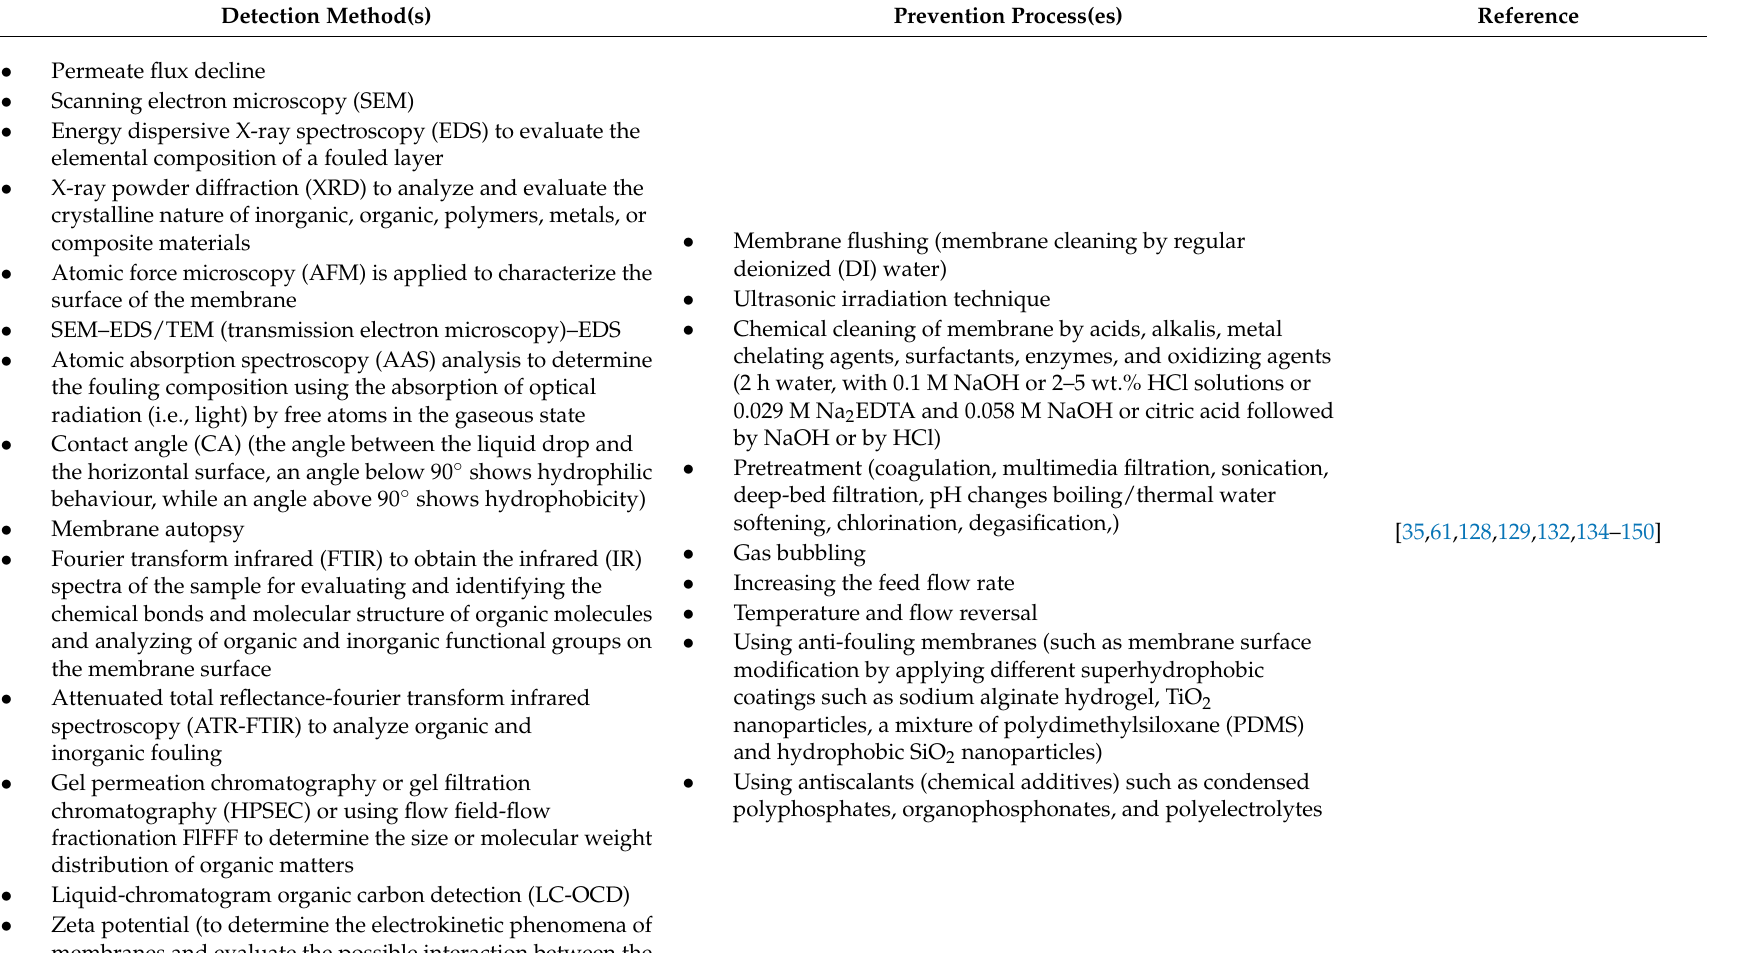
Table 7. Summary of detection and prevention methods for membrane